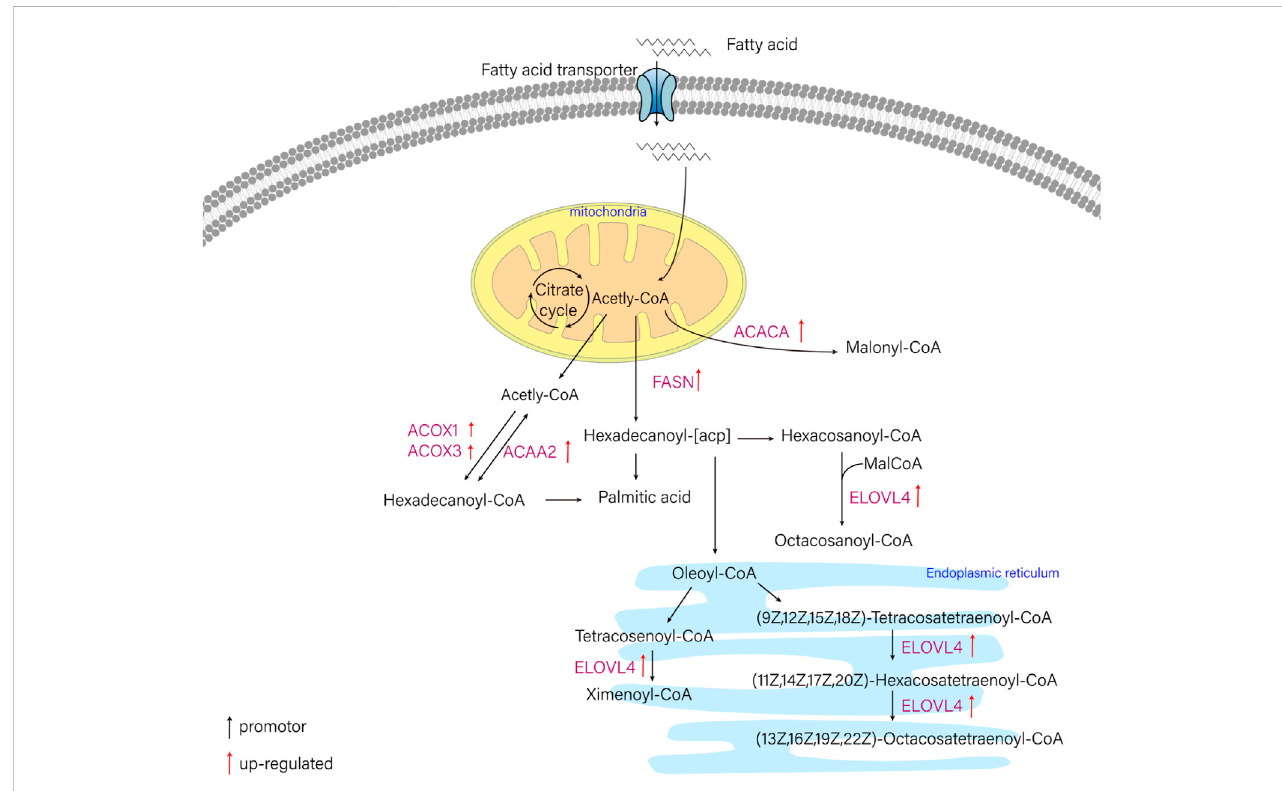
FIGURE 5 Theschematicdiagramoffatty acidmetabolismpathway.ELOVL4 (elongationofvery long chainfatty acidsprotein4),ACACA (acetyl-CoA carboxylase/